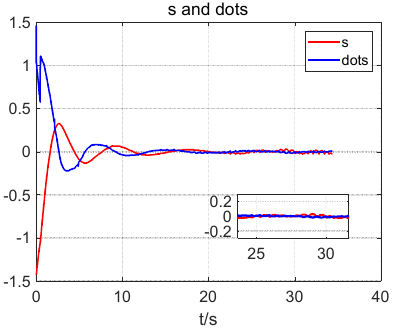
Figure 14. Sliding mode variable and its differential coefficient curve.